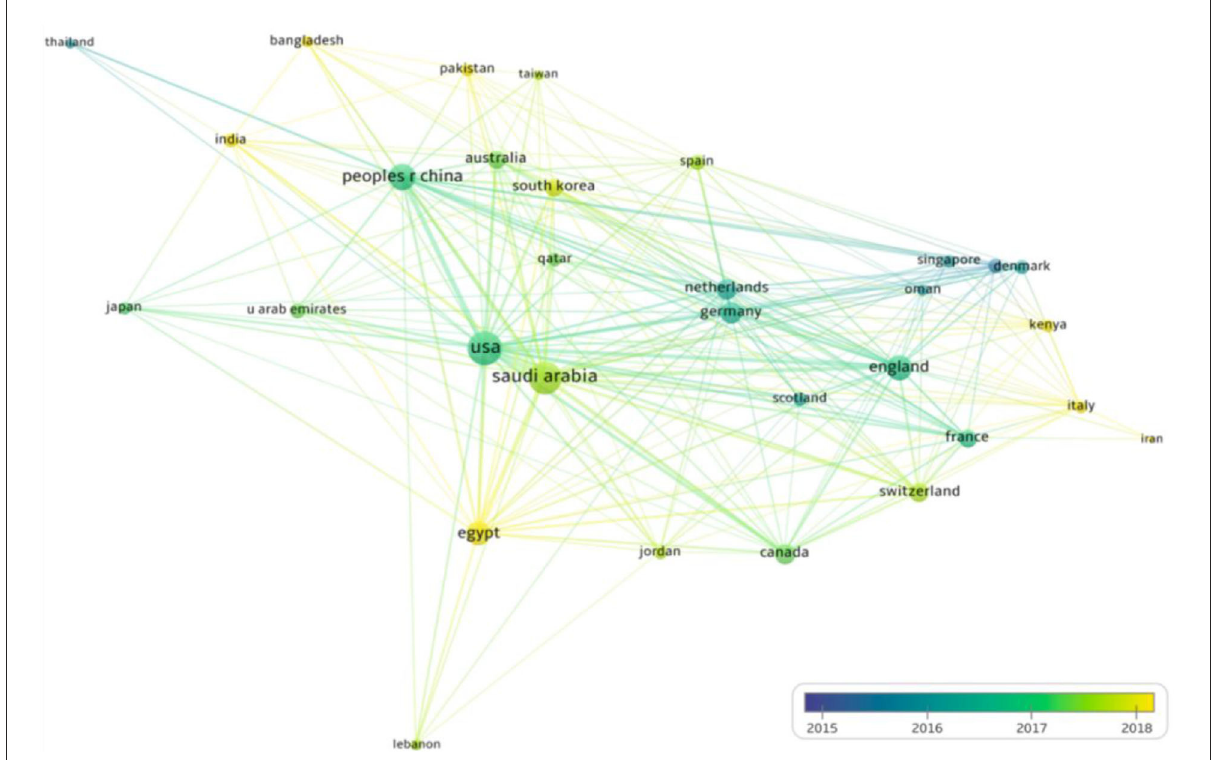
FIGURE5 Co-authorship countries or regions overlay visualization over time (years). The thicker the line between two countries or regions, the stronger the collaboration, while the bigger the node, the higher the contribution